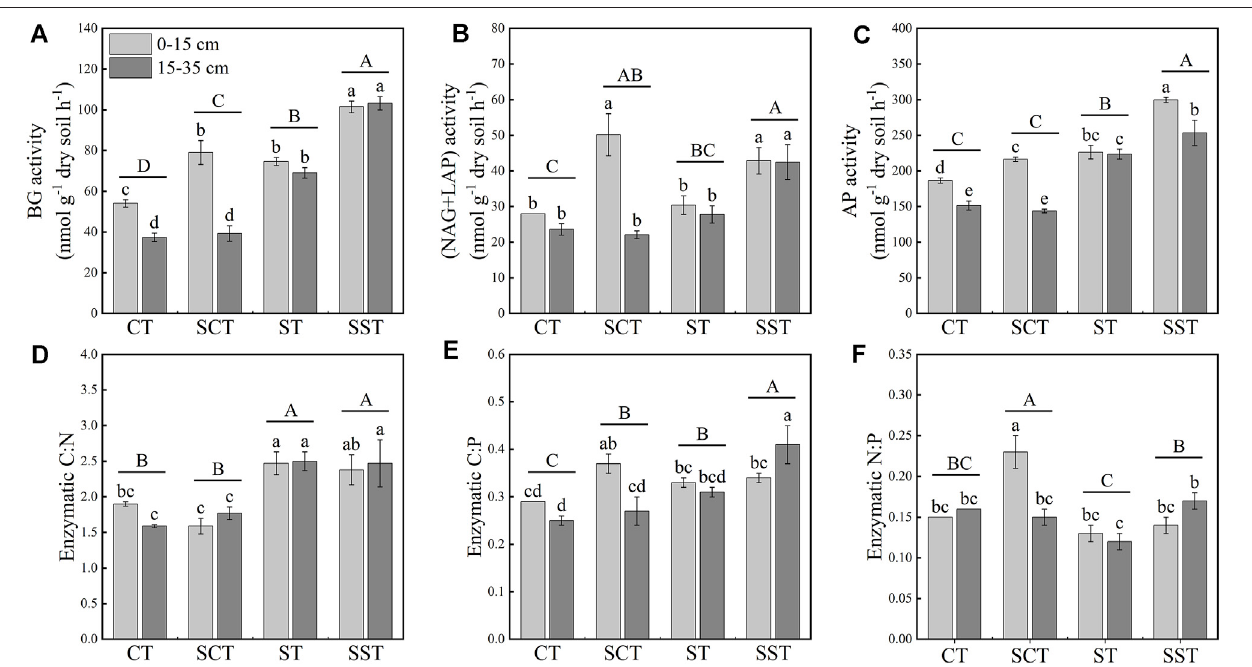
FIGURE 2 | Responses of the activities of soil extracellular enzymes to tillage and straw management in the 0 – 15 and 15 – 35 cm layers (A – C) . Responses of enzymatic activity ratios to tillage and straw management in the 0 – 15 and 15 – 35 cm layers (D – F) . Different capital letters represent signi fi cant differences among four different treatments. Different lowercase letters represent signi fi cant differences among four different treatments in different soil layers. See Materials and methods for abbreviation de fi